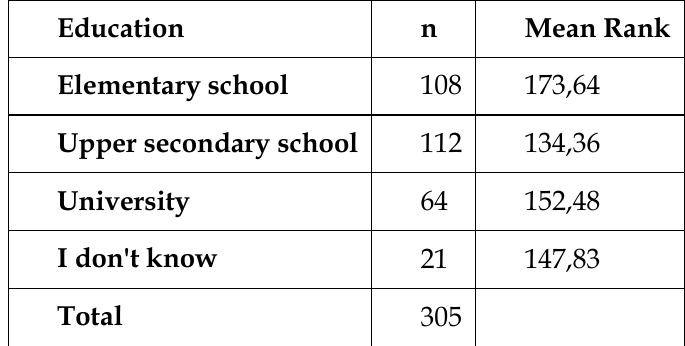
Figure 9. Trust towards the health centre and education. Percentage per reported value on scale 5-1 Elementary school n=108 (100%); Upper secondary school n=112 (100%); University or higher n=64 (100%); I don’t know n=21 (100%). Total n=305. Respondents reporting ‘Elementary school’ as highest educational level seem to express highest trust. Table 21. Trust towards the health centre and education. Kruskal-Wallis mean